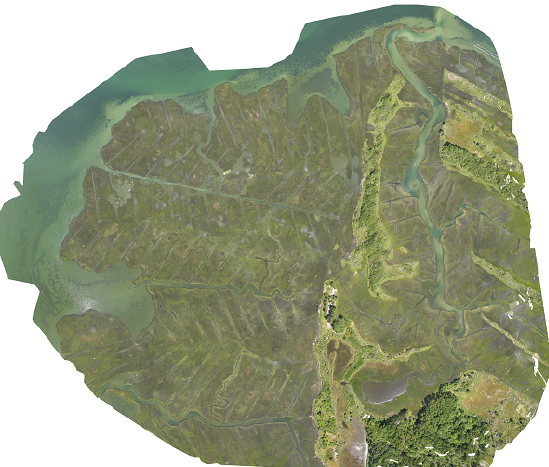
Figure 5. Low Tide Orthomosaic